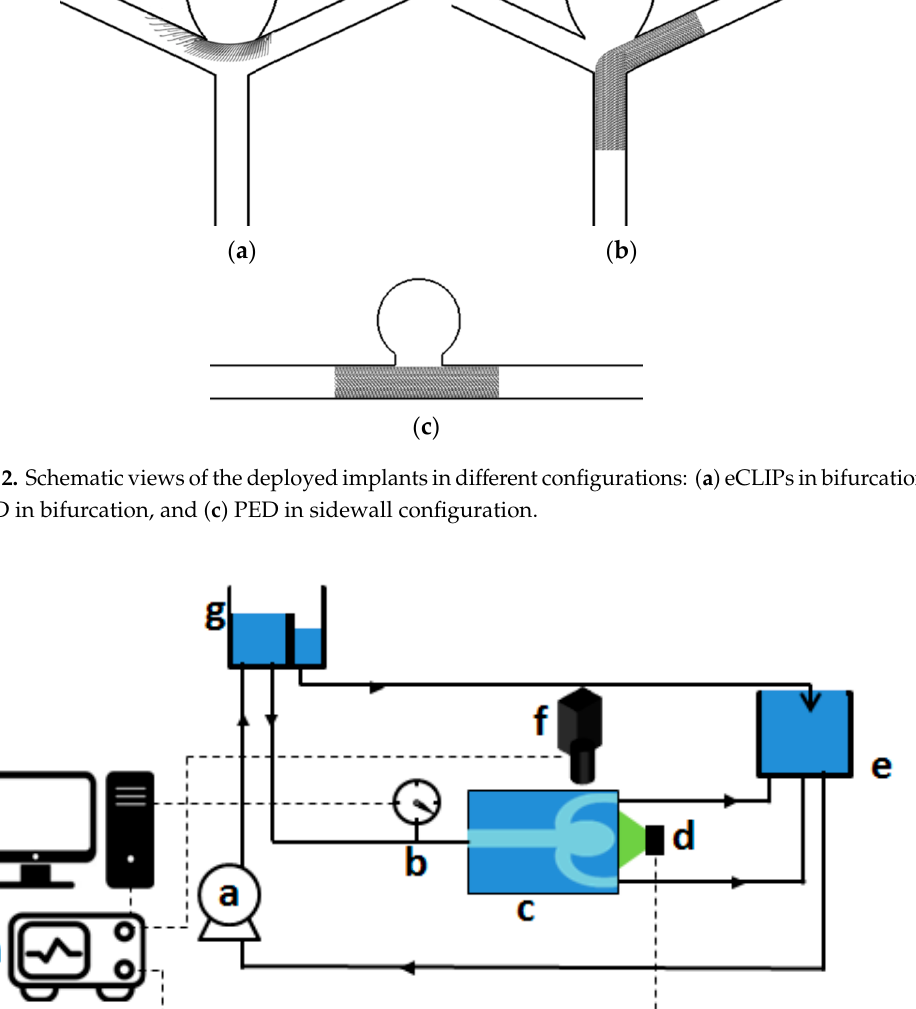
flowmeter, ( c ) phantom box, ( d ) LED light source, ( e ) header tank, ( f ) PIV camera, ( g ) reservoir (header tank with weir), ( h ) control platform.